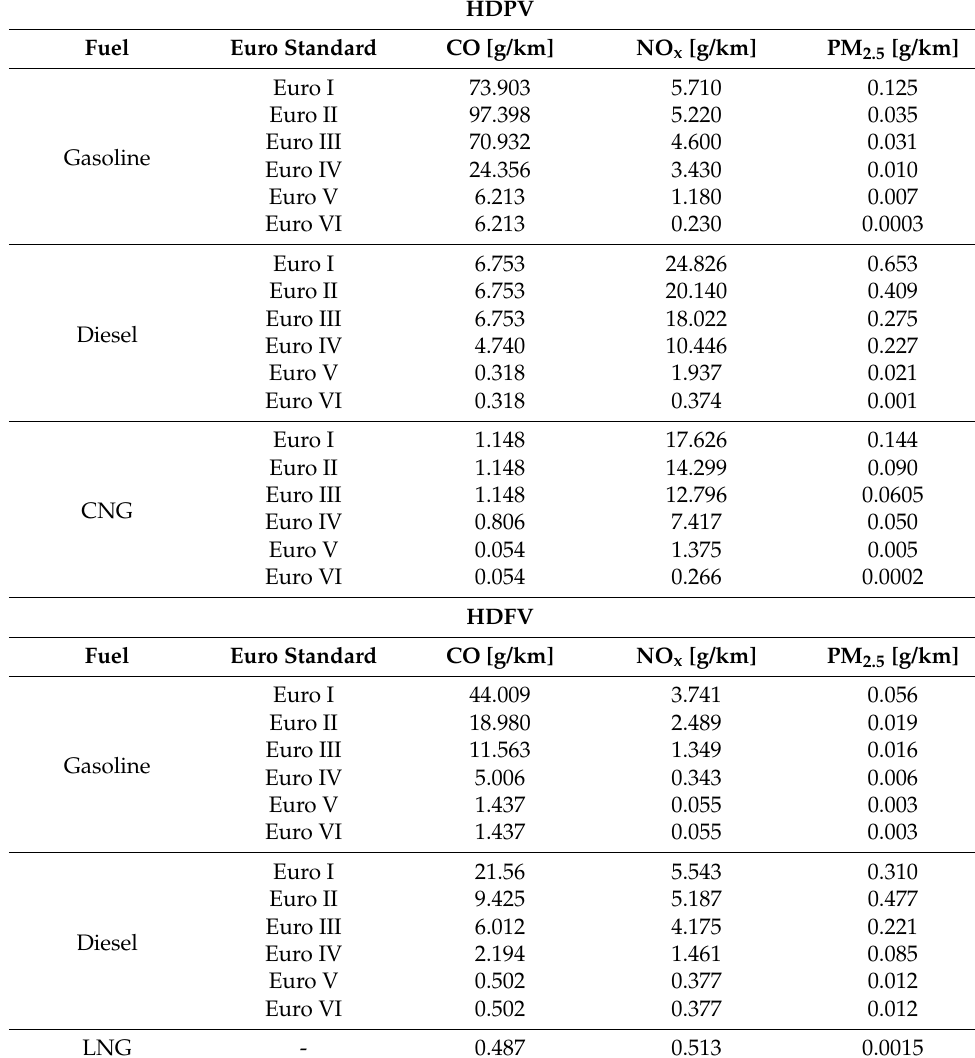
Table A1. Emission factors for HDPV and HDFV